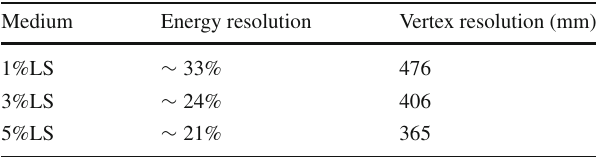
Table 1 The energy and vertex resolutions for different WbLS concen- trations (1%, 3%, and 5%) with a 0.1%